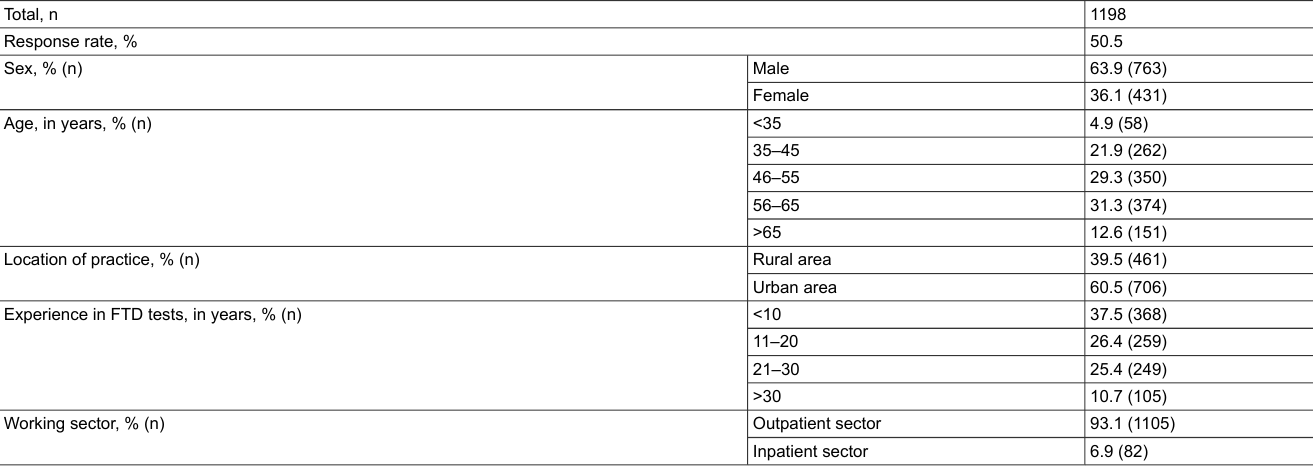
Table 1: Sociodemographic characteristics of respondents.